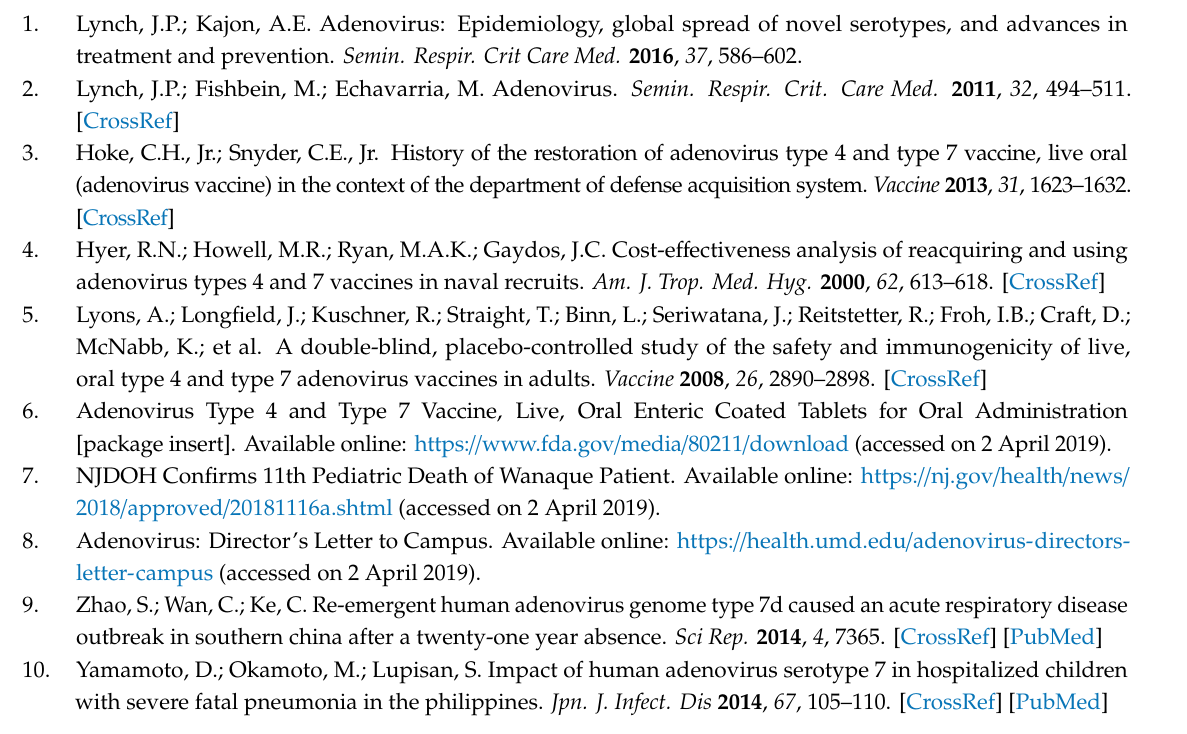
Figure S1: Ad7 Fiber Expressing cell line, Figure S2: Overlapping PCR products used to create the scAd7 virus, Table S1: Infectious units of each virus as determined by